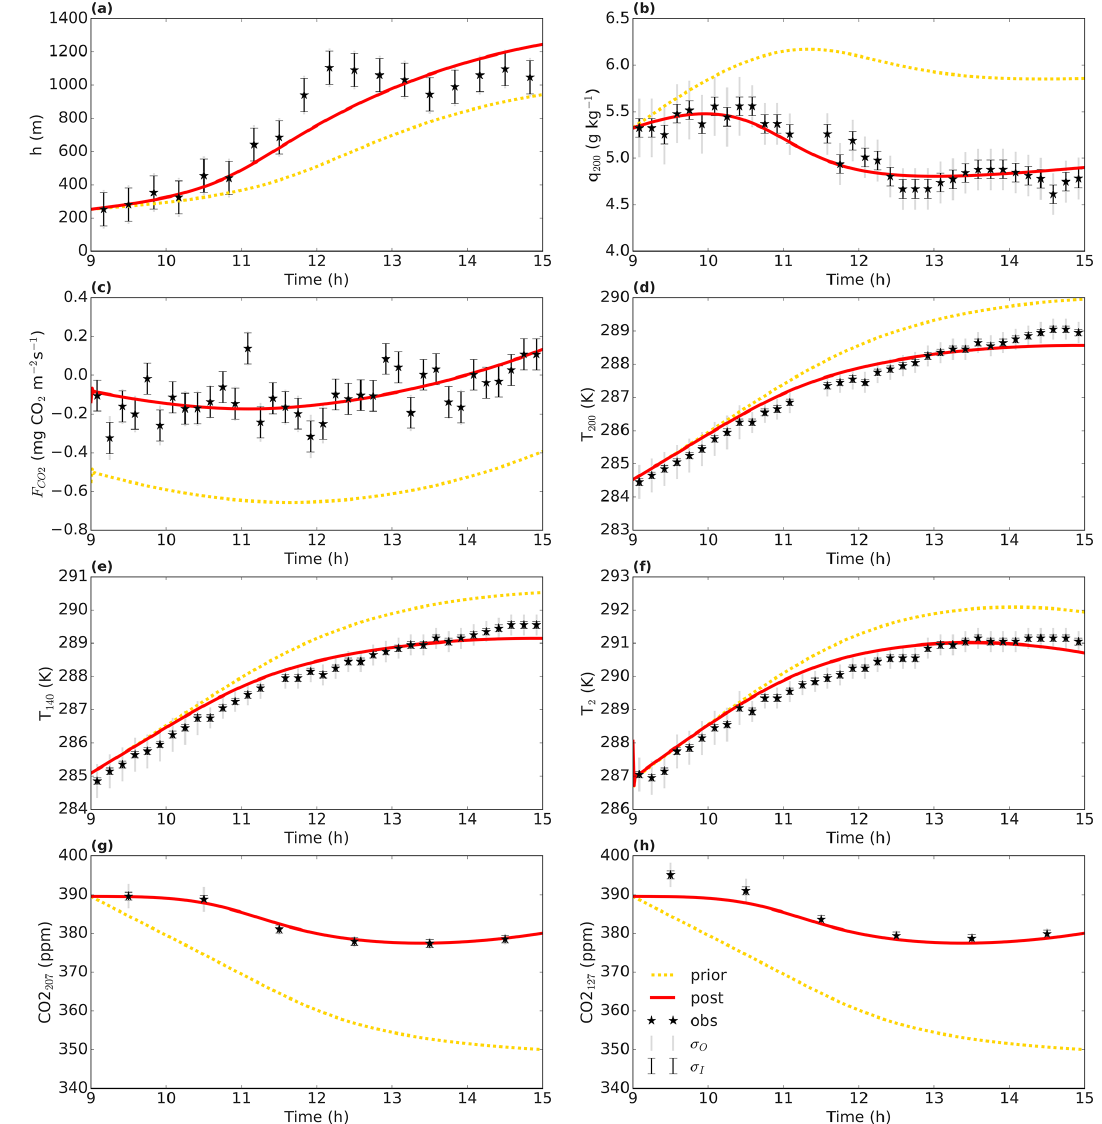
Figure 5. Optimisation for the Cabauw data. The full red line shows the optimised model (“post” means posterior), and the dotted yellow line is the prior model. The observations are shown by a black star. The error bars show the measurement error standard deviation σ I and total error standard deviation σ O on the